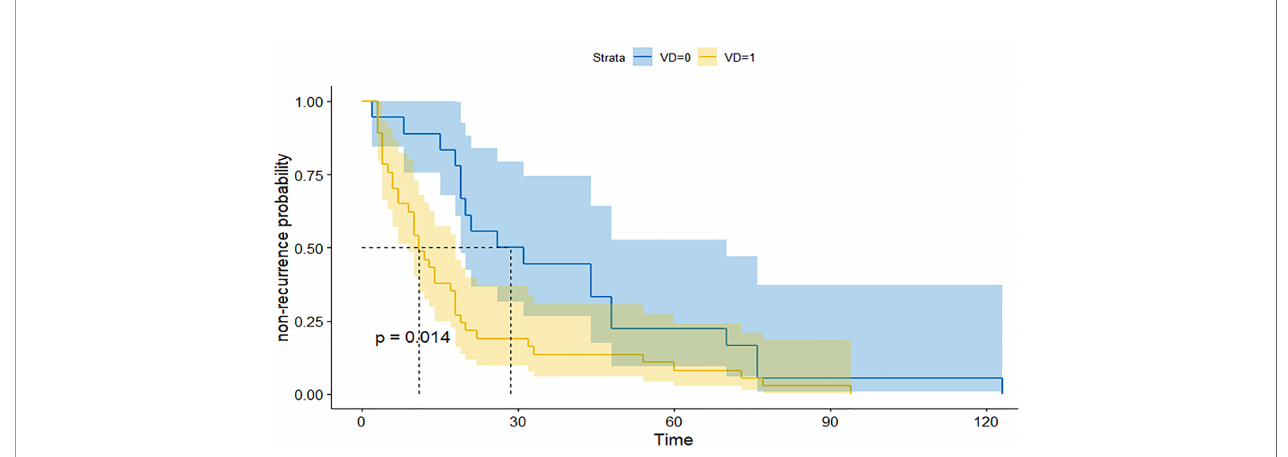
FIGURE 2 | ROC for the prediction of recurrence by several indexes: The recurrent time of patients with high V-D value (yellow line) was signi fi cantly shorter than patients with low V-D value (blue line).